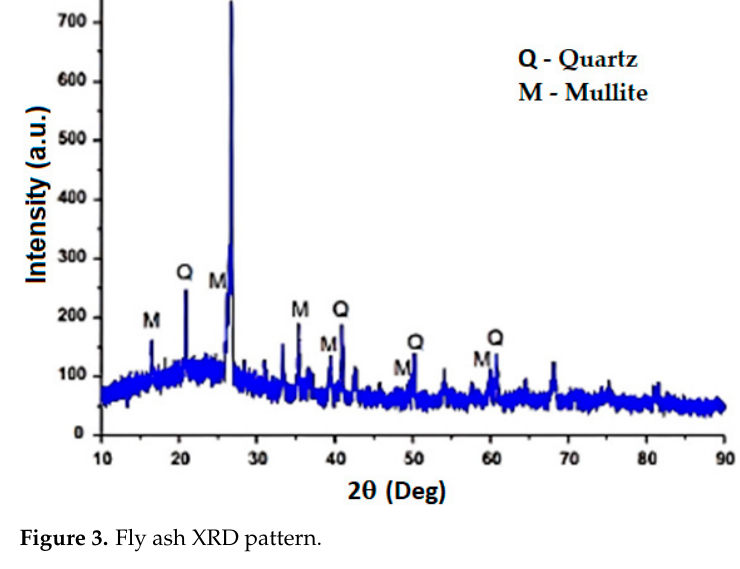
Figure 3. Fly ash XRD pattern.